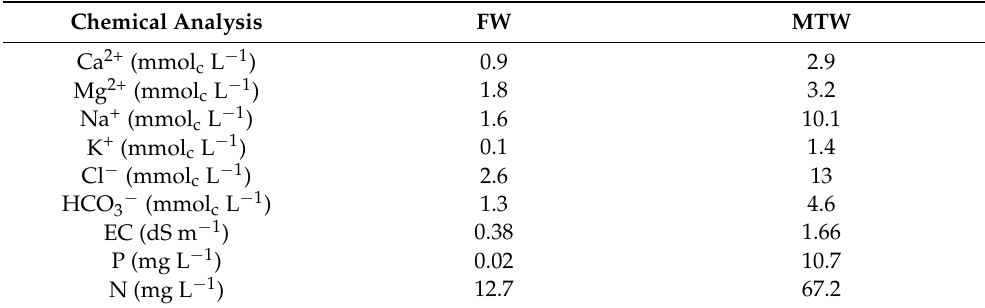
Table 2. Chemical analysis of freshwater (FW) and municipal treated wastewater (MTW) in the city of Russas, Ceará, Brazil. Chemical Analysis